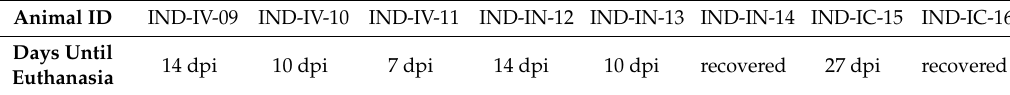
Table 1. Summarized length of protocol for sheep inoculated with SPPV-“India / 2013 / Surankote”.